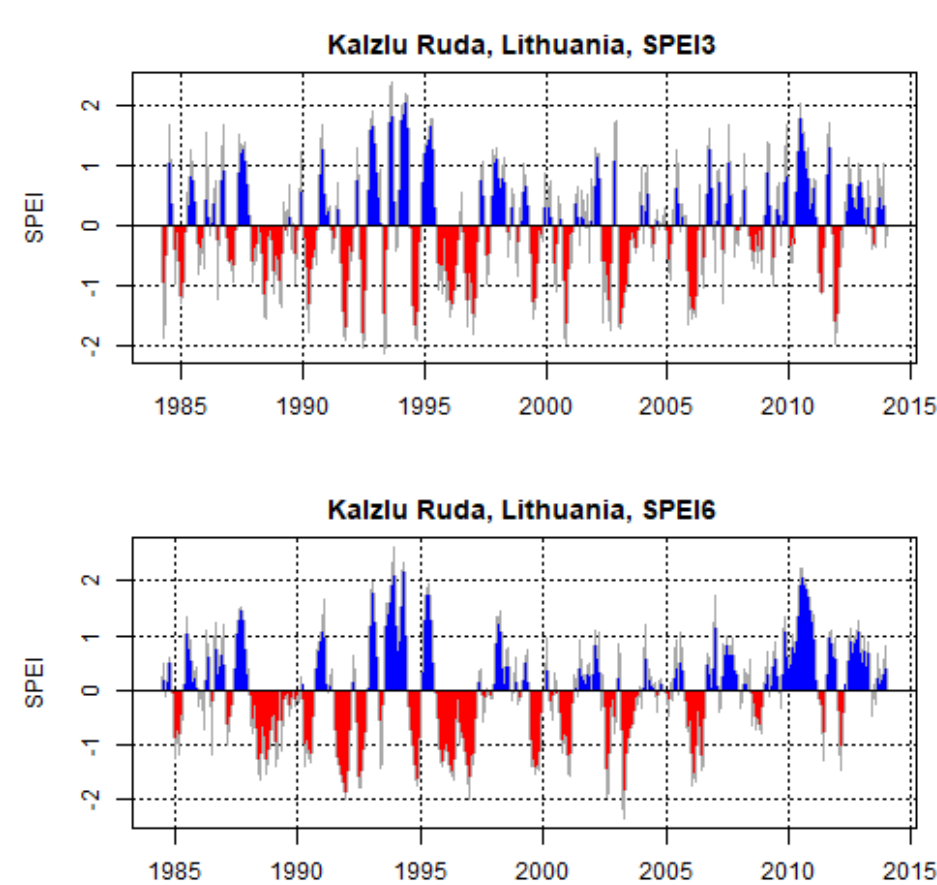
Figure 4. Temporal variations of standardized precipitation evapotranspiration index (SPEI) inte- grated over three and six months for the 1984–2013 period.